Question: How would you classify this visualization?
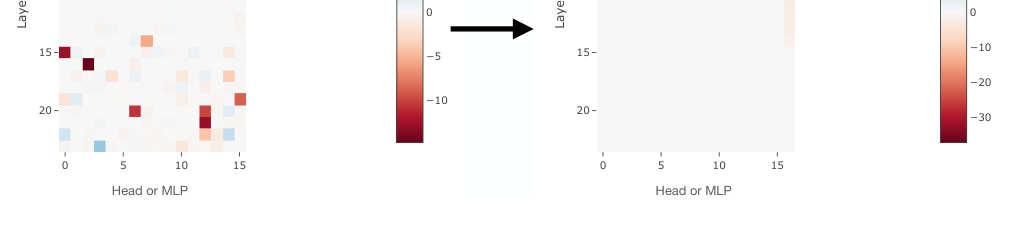
Answer: heatmap